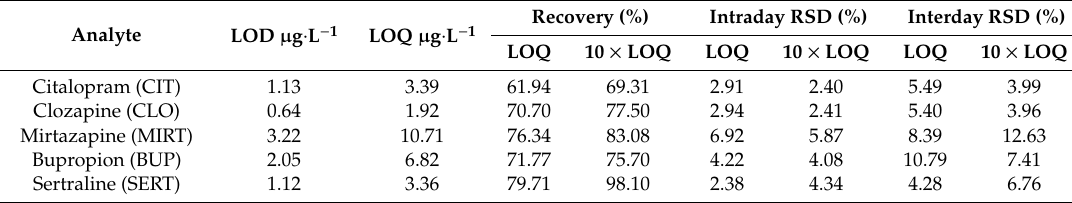
Table 3. Analytical parameters of Milli-Q water samples (n =